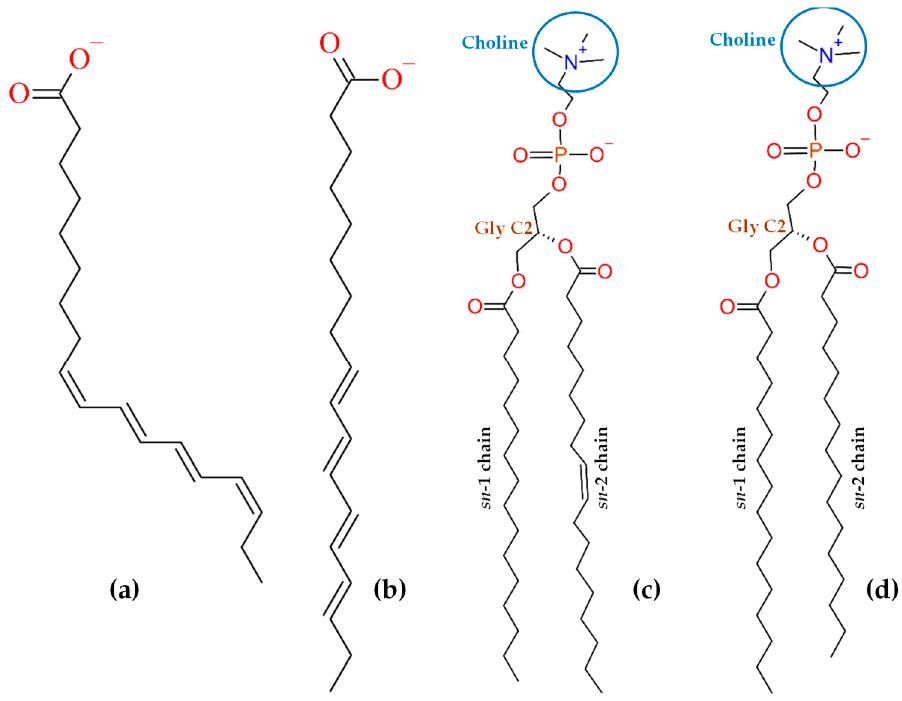
Figure 1. Structures of ionized cis-parinaric acid ( c -PnA, a ) and trans-parinaric acid ( t -PnA, b ), and phospholipids POPC ( c ) and DPPC ( d ), with indication of relevant atoms or groups of atoms.